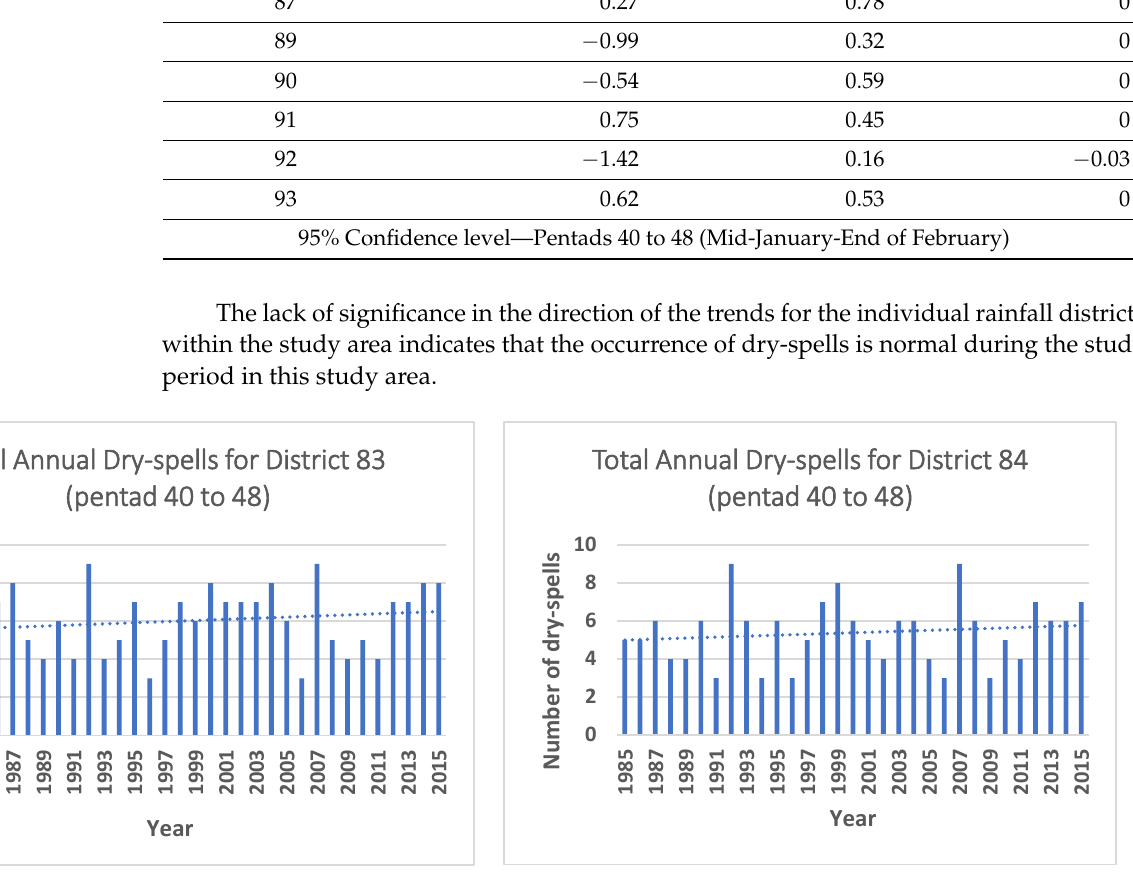
Table 4. Mann–Kendal and Sen’s slope analysis at 95% confidence interval for SAWS rainfall dis ‐ tricts during pentads 40 to 48 (1985 to 2015).